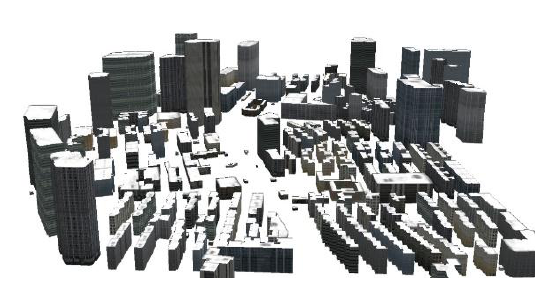
Figure 1. 3D Building Models